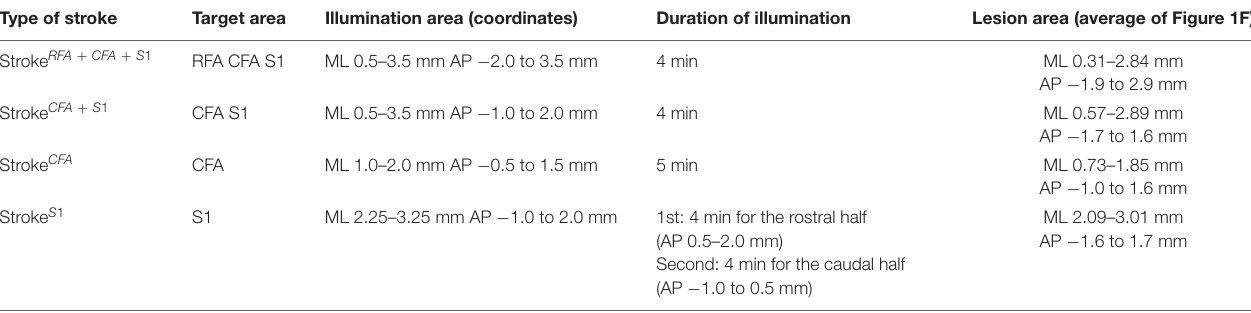
TABLE 1 | Summary of lesion inductions in the photothrombotic stroke